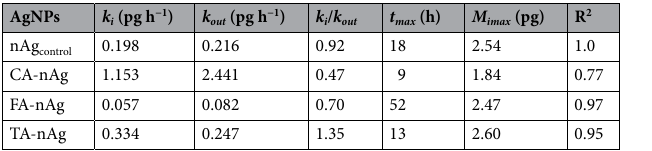
Table 2. Fitting parameters for nAg control , CA-nAg, FA-nAg and TA-nAg bound to A549 cell with Langmuir adsorption model (incubated AgNPs concentration was 10 μg ml −1 ).